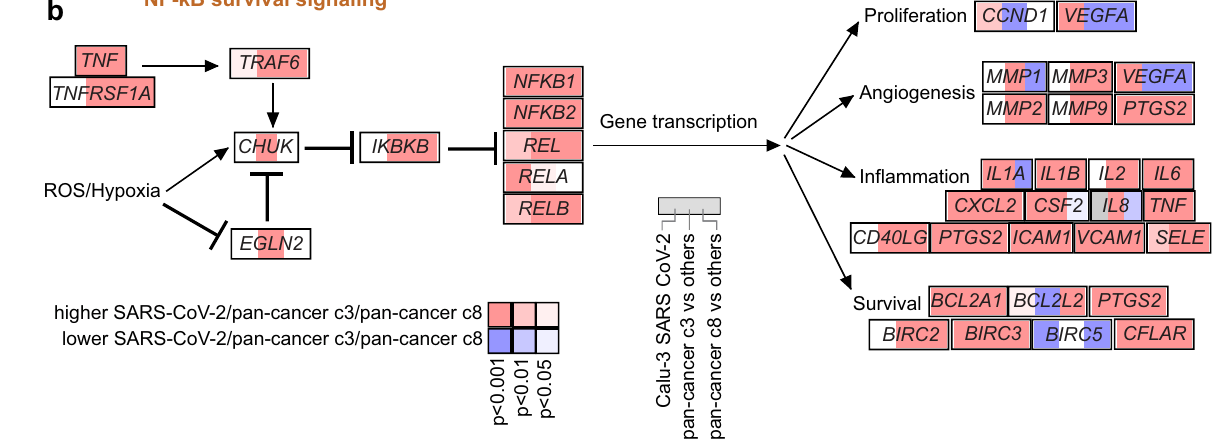
Figure 7. The SARS-CoV-2 transcriptional signatures are manifested in specific pan-cancer classes involving multiple tissues of origin, the immune response, and NF-κB signaling. ( a ) RNA-seq profiles of 10,224 cancer cases across 32 major types were previously classified into ten molecular-based pan-cancer “classes” (profiles normalized within their respective cancer types) 14 . Differential SARS-CoV-2-associated expression patterns common to all three cell lines (NHBE, A549, Calu-3) or found for just one or two cell lines (from Fig. 2b,c) are shown for both the in vitro SARS-CoV-2 infection dataset and the pan-cancer dataset. Gene order is the same across both datasets. Human tumor profiles are ordered by pan-cancer class, with cancer type based on tissue of origin and histopathology indicated along the bottom. Heat map contrast (bright yellow/blue) is threefold change from control for SARS-CoV-2 dataset and 1 SD from median for pan-cancer dataset. Selected patterns of manifestation of SARS-CoV-2 signatures within the human cancers are highlighted, involving c3 class (immune-related) and c7 and c8 classes (mesenchymal- or stroma-related). Under the differential expression heat maps, scores for each SARS-CoV-2 signature across the human tumor profiles are represented (orange- cyan heatmap). Gene expression-based signatures of immune cell infiltrates 38 and selected genes are also represented across the human tumor profiles (NK cells, natural killer cells). ( b ) Diagram of the NF-κB signaling pathway (from wikiPathways 18 , full pathway name “Photodynamic therapy-induced NF-κB survival signaling”). For each gene shown, three different expression comparisons are represented: SARS-CoV-2 infection versus control in Calu-3 cells (left square), pan-cancer c3 class versus the other tumors (middle square), and pan-cancer c8 class versus the other tumors (right square). Red, high expression in SARS-CoV-2-infected cells, c3 human tumors, or c8 human tumors, as indicated. p values by t test using log-transformed values. See also Supplementary Data